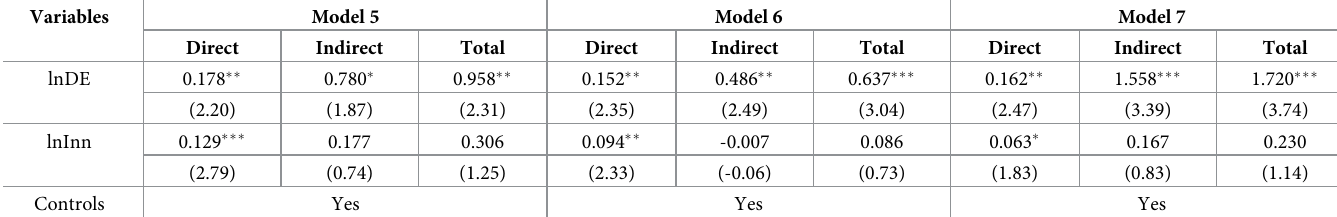
Table 9. Robustness test